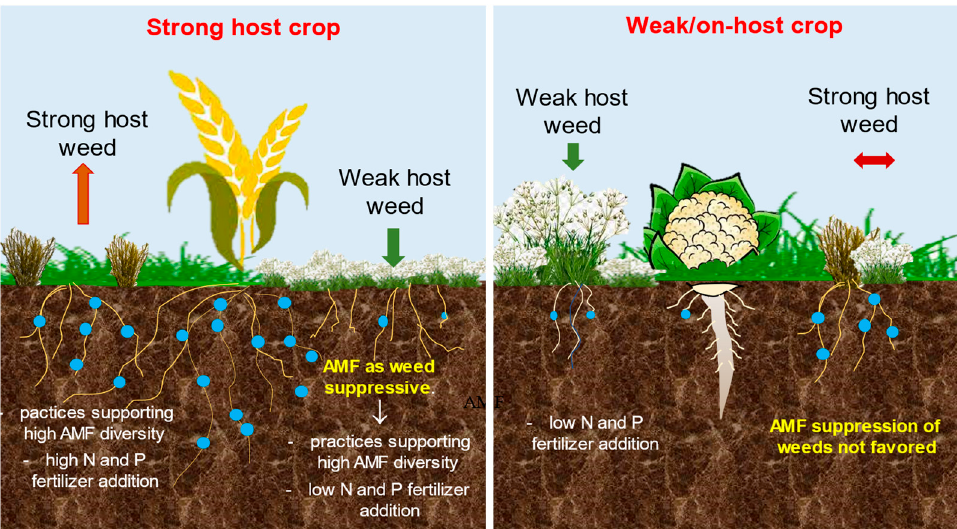
Figure 3. Recommended management decisions based on host status, and crop-weed community composition for use of arbuscular mycorrhizal fungi (AMF) in weed control. Adapted from [19].